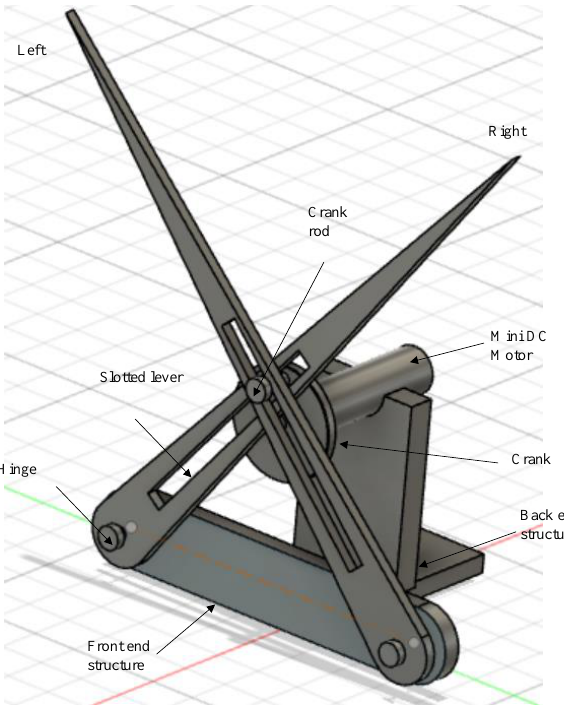
Figure 2. CAD model of SC-SDL Design-I motor driven Single-Crank-Dual-Slotted Lever Mechanism for flapping actuation.